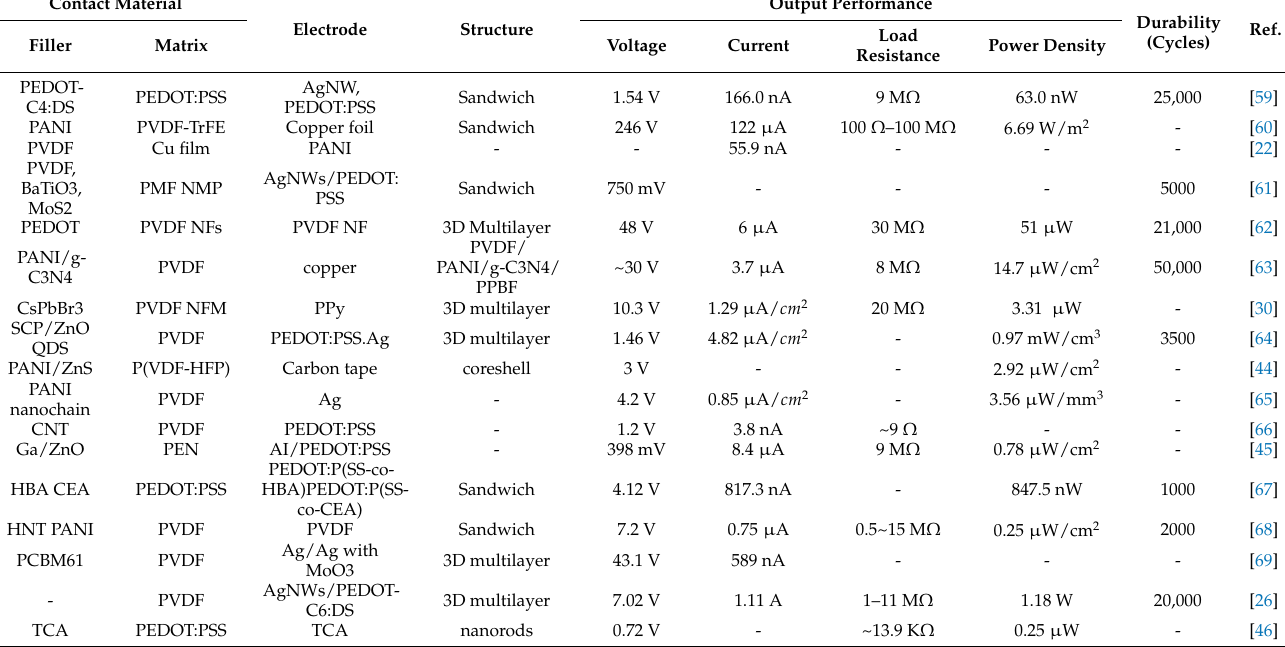
Table 1. Comparison of performance of selected conducting polymer-based